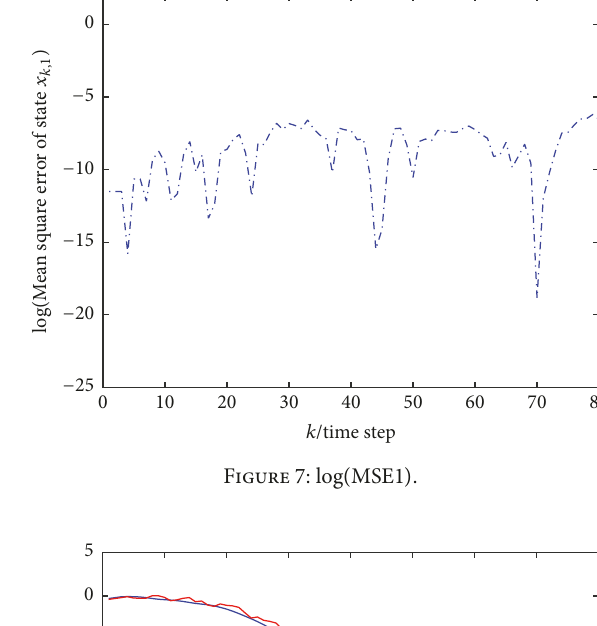
Figure 5: The trajectories of 𝑥 1 𝑘 .